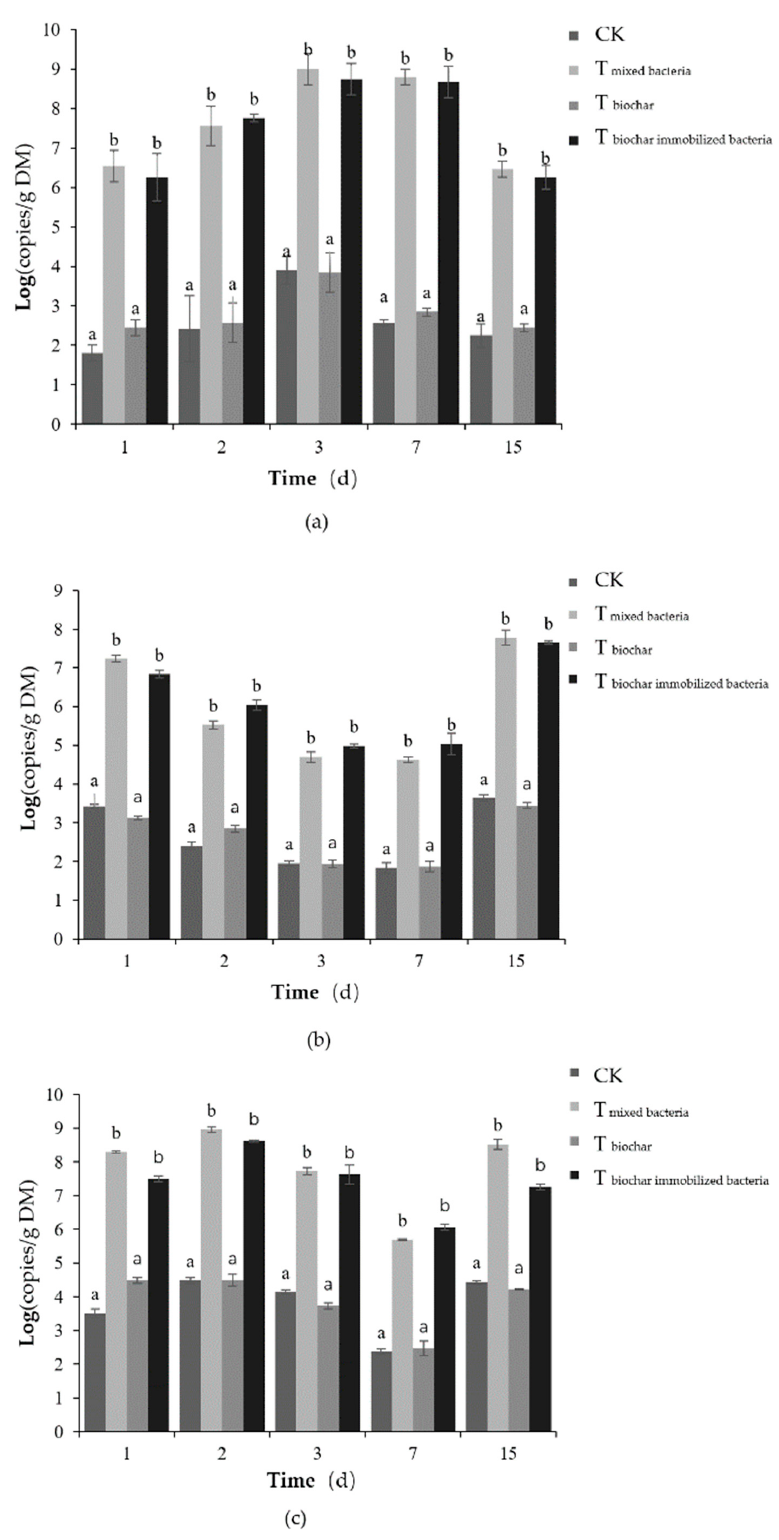
Figure 6. Changes in the number of Bacillus stearothermophilus ( a ), Candida utilis ( b ), and Bacillus subtilis ( c ) for different composting treatments (CK: as the control); Note: Error bars represent the standard deviation ( n = 3); An analysis of variance in the figure is the same day, data comparison between the different composting treatments; a–b Columns reporting different letters are significantly different ( p < 0.05).